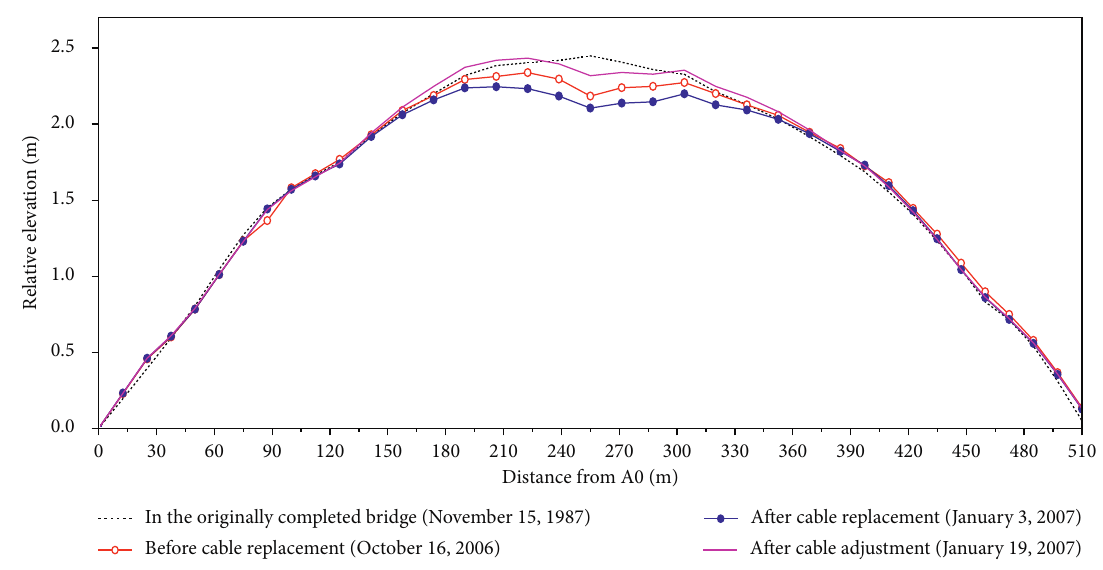
Figure 17: Measured geometry profiles of bridge deck in the Yonghe